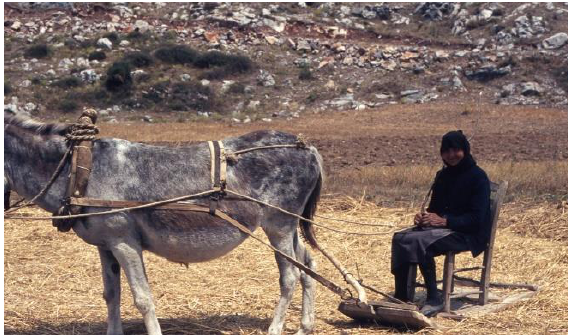
Figure 2 . Recent Traditional Threshing scene in Cyprus during 60s. © Cyprus Exploration unlimited